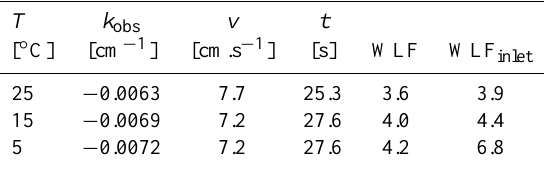
Table 2. Sulfuric acid losses in the lower half of the nucleation chamber at three temperatures, T (25, 15 and 5 ◦ C), RH ∼ 50%, where k obs is the observed loss rate coefficients, v is mean flow ve- locity, t is residence time, WLF is the wall loss factor, and WLF inlet is the wall loss factor estimated for CIMS’ inlet sampling